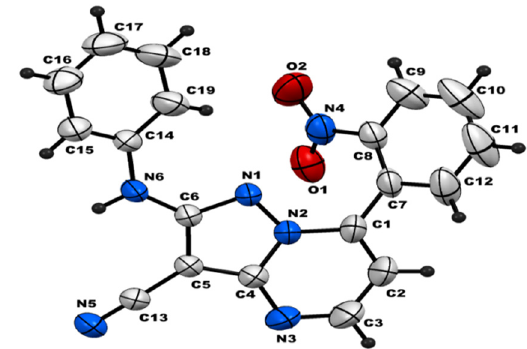
Figure 4: ORTEB diagram of compound 6a ( X - ray )